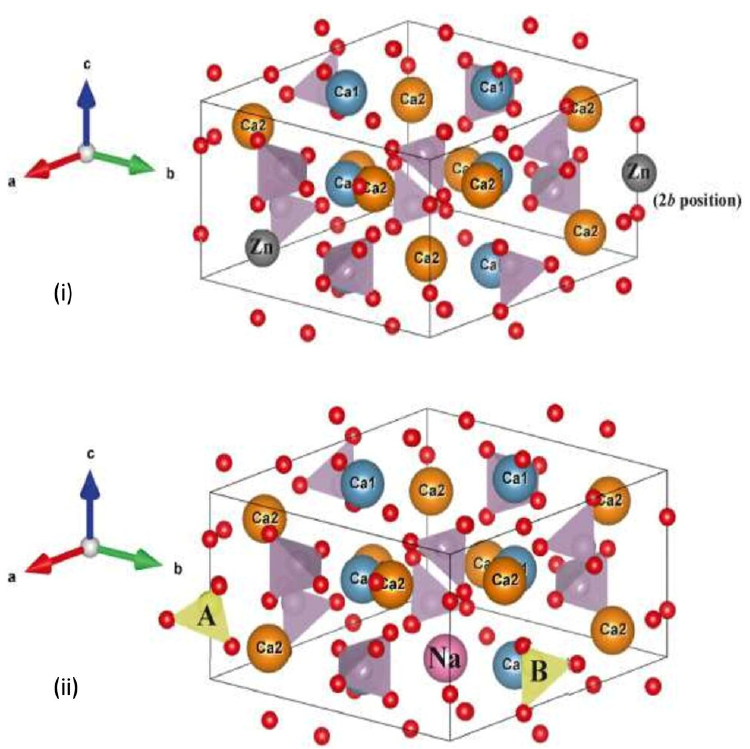
Figure 4. The crystal structure of ( i ) zinc-substituted hydroxyapatite, where the substitution of Zn on Ca2 site and at c -axis in the 2 b position between two oxygen ions; ( ii ) A- and B-type carbonate ion substitution in hydroxyapatite structure, Ca = calcium, Na = sodium; Zn = zinc [62].